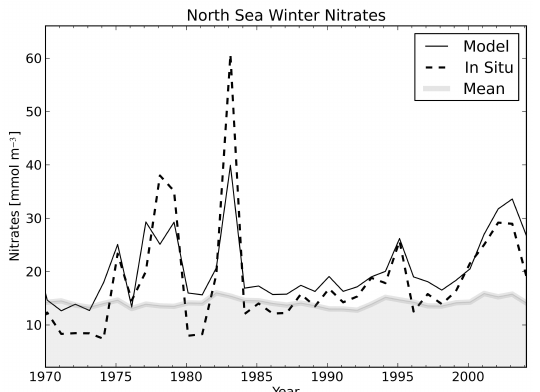
Fig. 14. North Sea mean winter nitrates time series: the black line is the matched model mean winter nitrates, the dashed line the mean winter in situ nitrates, and the grey area shows the MLD-averaged mean nitrate of the North Sea.